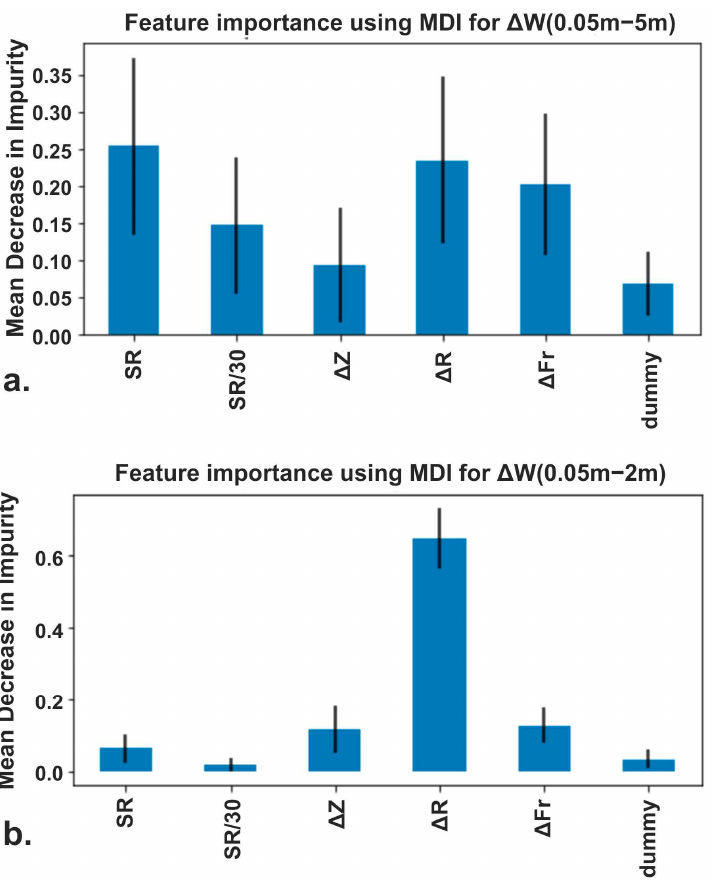
Figure 18. Random Forest-calculated feature importance for fixed sinuosity ratio SR, rolling SR per 30 cross-sections, ∆ Z (0.05 m–5 m), ∆ R (0.05 m–5 m), ∆ Fr (0.05 m–5 m), and a dummy variable (random noise) using Mean Decrease in Impurity (MDI) for ( a ) ∆ W (0.05 m–2 m) and ( b ) ∆ W (0.05 m–5 m).